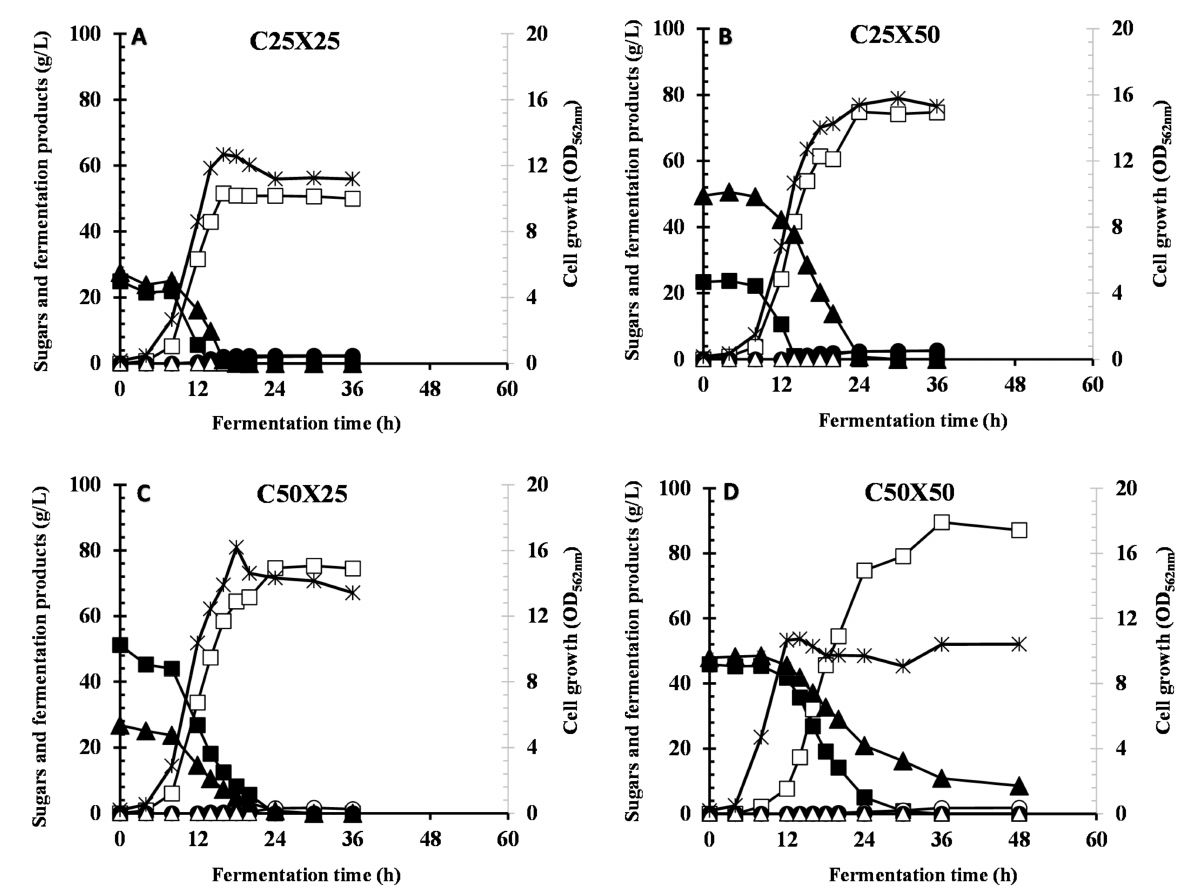
Figure 2. Effect of different cellobiose/xylose concentrations on growth and lactic acid production by B. coagulans Azu-10. ( A ) fermentation of 25 g/L cellobiose and 25 g/L xylose [C25X25]; ( B ) fermentation of 25 g/L cellobiose and 50 g/L xylose [C25X50]; ( C ) fermentation of 50 g/L cellobiose and 25 g/L xylose [C50X25]; ( D ) fermentation of 50 g/L cellobiose and 50 g/L xylose [C50X50]. Symbols: (cid:4) , cellobiose (g/L); (cid:78) , xylose (g/L); (cid:3) , lactic acid